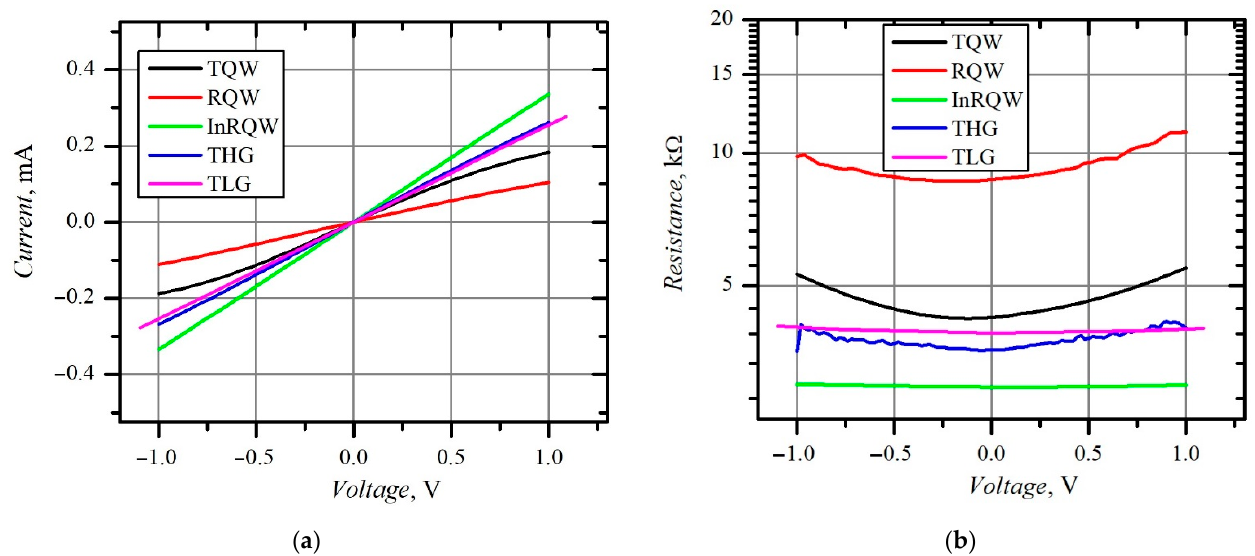
Figure 3. I-V characteristics ( a ) and dependence of electrical resistance on bias voltage ( b ) of different planar MW diodes; all measured in the dark. Table 2. Sheet resistance R sh and specific contact resistance ρ c of the planar, asymmetrically necked diodes in dark and under illumination.